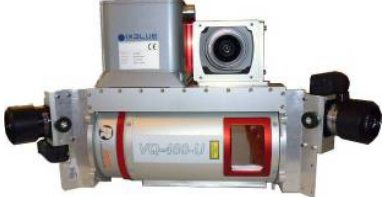
Figure 2: The reference LiDAR sensorhead, mounted with Riegl VQ480U